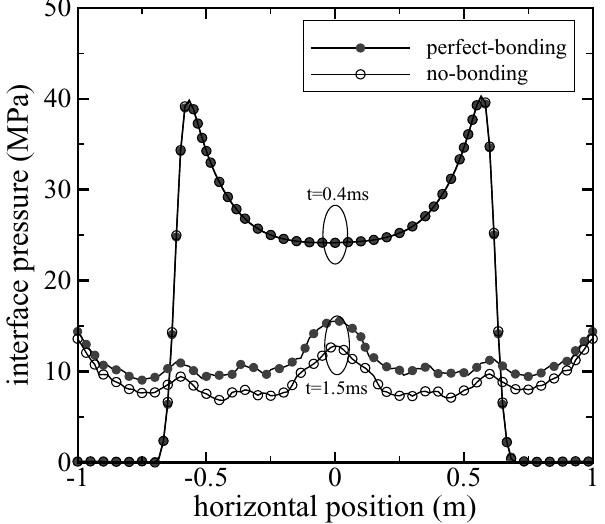
Fig. 6. Comparison of the fluid-solid interface pressure profiles between the perfect- and no-bonding sandwich plates with clamped ends.